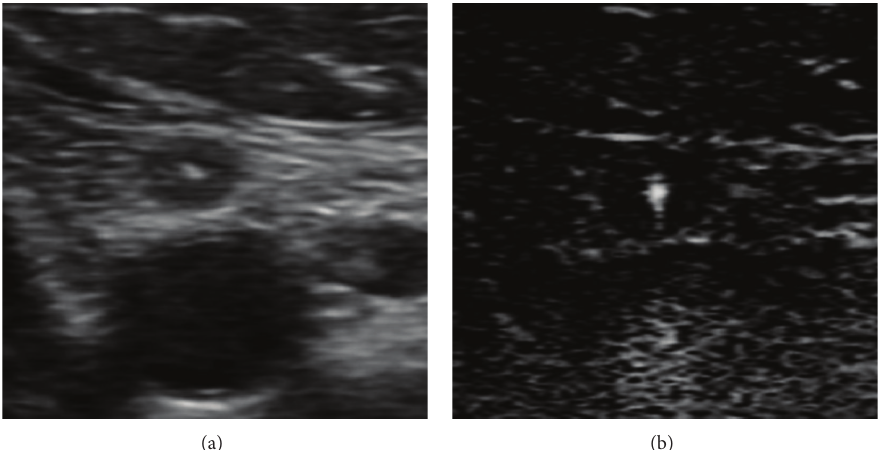
Figure 3: Small metastatic lymph node at B-mode and BFI examination in patients with papillary thyroid cancer. The lymph node presents BFI-TS without any suspect US features.